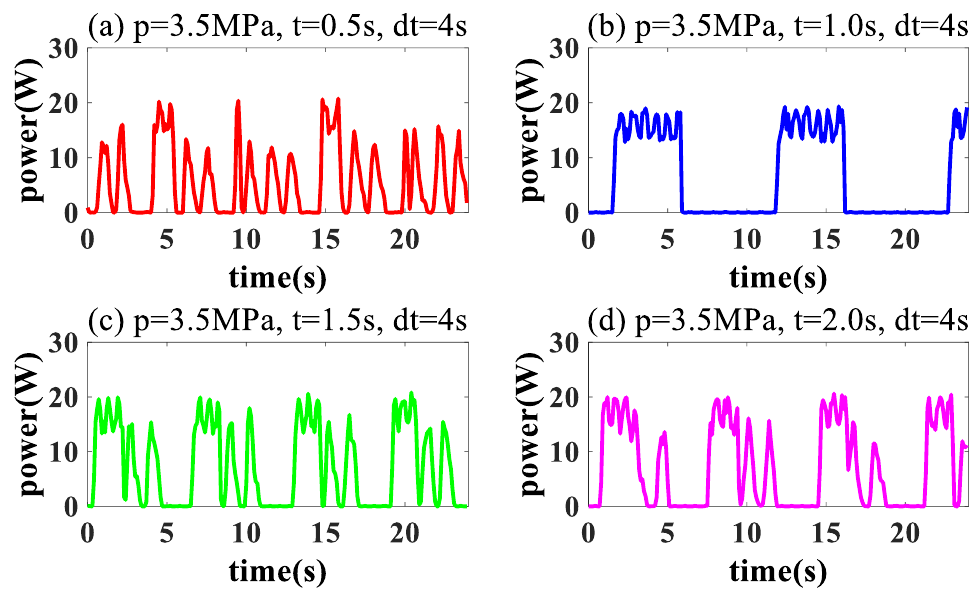
Figure 10. Output power under different delay times (trigger pressure is 3.5 MPa).